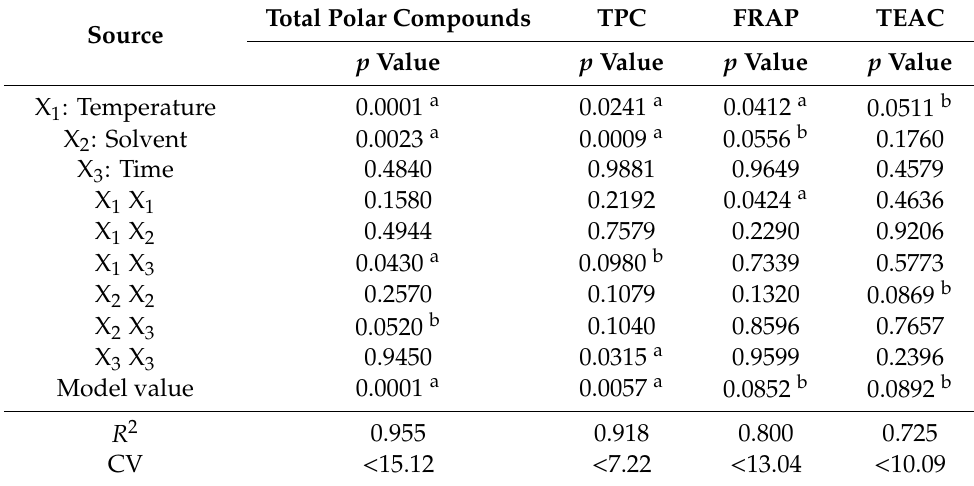
Table 7. Analysis of variance (ANOVA) of the regression models in L. citriodora . Response variables: Total Polar Compounds, TPC, FRAP and